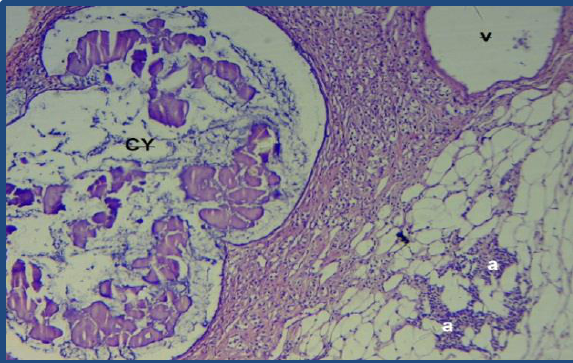
Figure, 14: Ultimobranchial gland showes: a- Lymphoid focci b- Cystic structure (CY) occupied the greater part of the gland (H and E stain, 10 X).